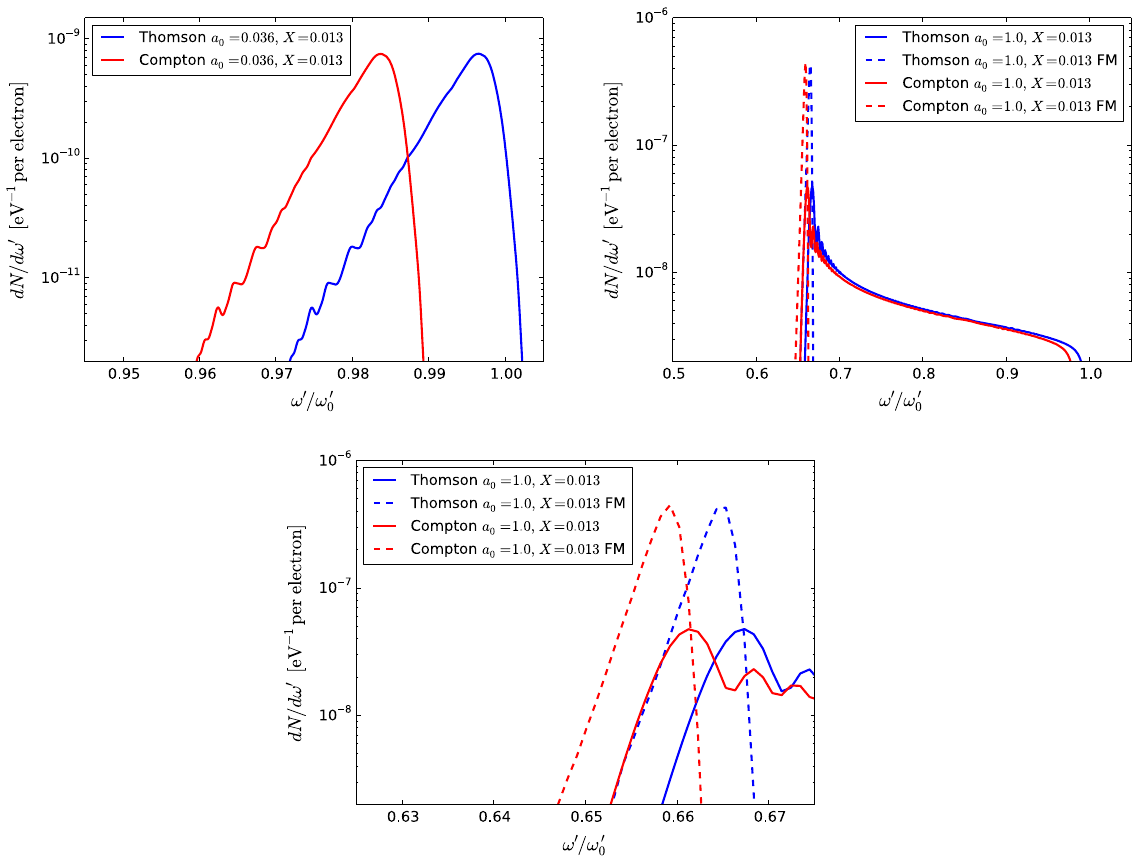
FIG. 5. Spectra for ELI-NP parameters, as listed in Table II. Left: Nominal parameters ( a 0 ¼ 0 . 036 ). Middle: a 0 ¼ 1 . 0 with and without FM. Normalized to the maximum of the FM spectrum. Nonlinear subsidiary peaks arising from the non-negligible value of the laser field strength parameter a 0 are evident. Right: Middle panel enlarged around the main peaks. Note that the y range for the plots in the middle and the right are the same and are scaled by a factor of 1000 from the y range in the panel on the